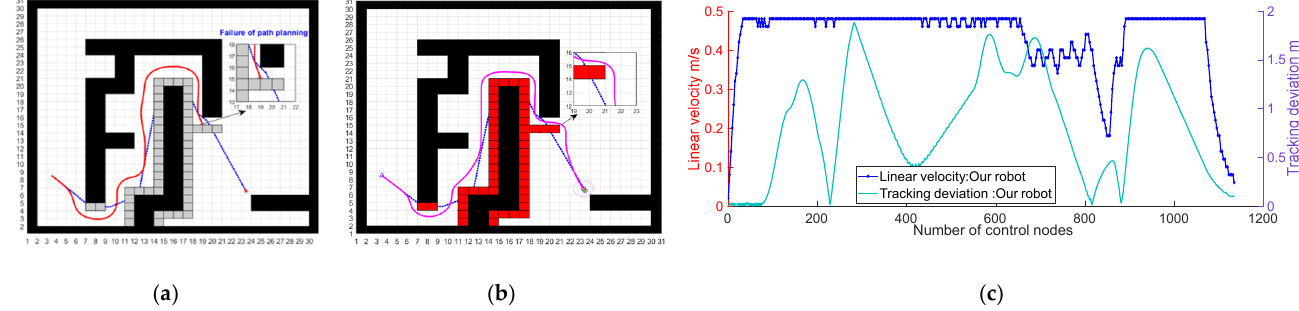
Figure 14. Map 1’s experimental results. ( a ) Traditional robot. ( b ) Our robot. ( c ) Two-coordinate plot of linear velocity and tracking deviation.